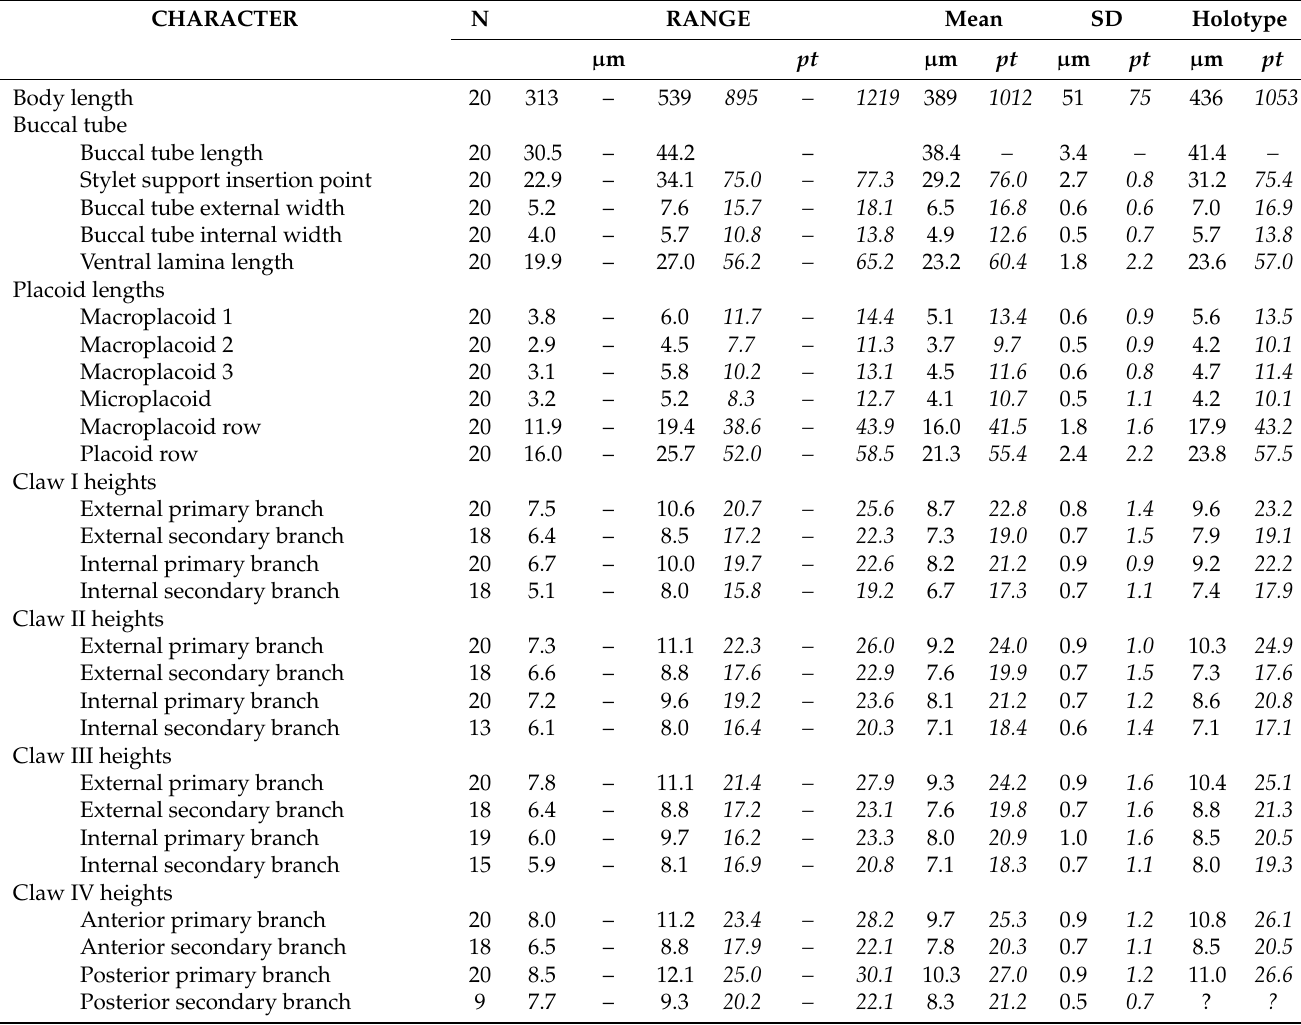
Table 3. Measurements [in µ m] and pt values of selected morphological structures of animals of Mesobiotus imperialis sp. nov. ; specimens mounted in Hoyer’s medium; N—number of specimen/structures measured, RANGE refers to the smallest and the largest structure among all measured specimens; SD—standard deviation.